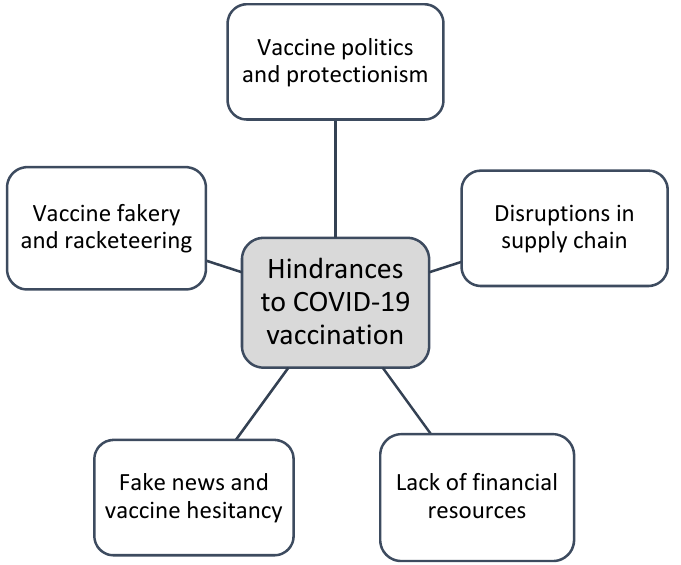
Figure 1. Hindrances to COVID-19 vaccination.